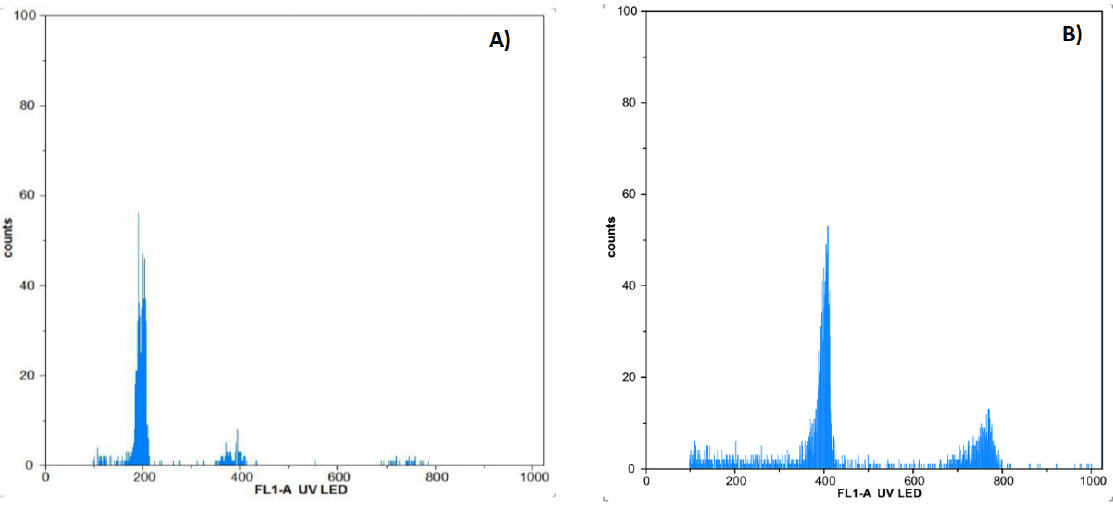
Figure 1. Histogram of flow cytometry analysis from C. fragrans : ( A ) histogram of control plant (diploid) and ( B ) polyploid plants (tetraploid).